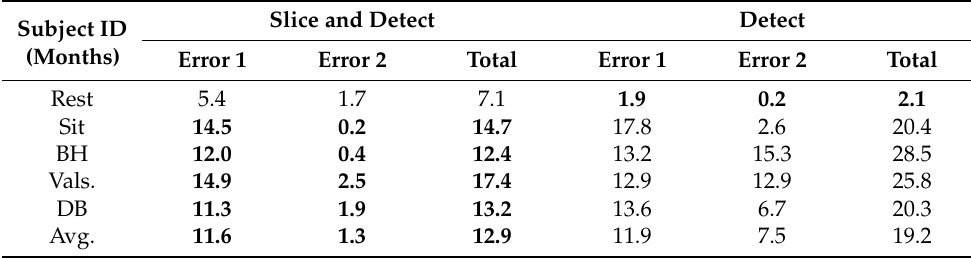
Table 2. Performance of Both Algorithms on Group